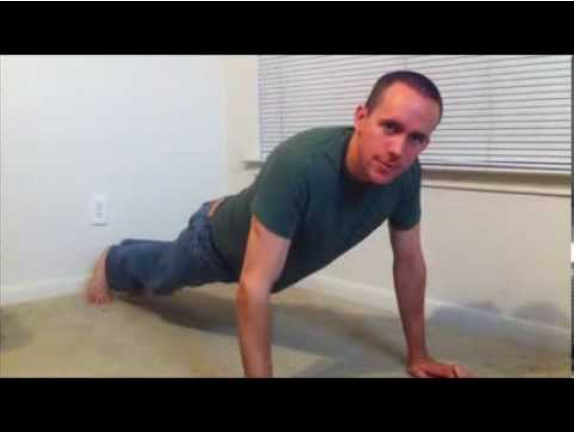
Figure 1: Barron Stone memorably demonstrates for and while loops (Stone